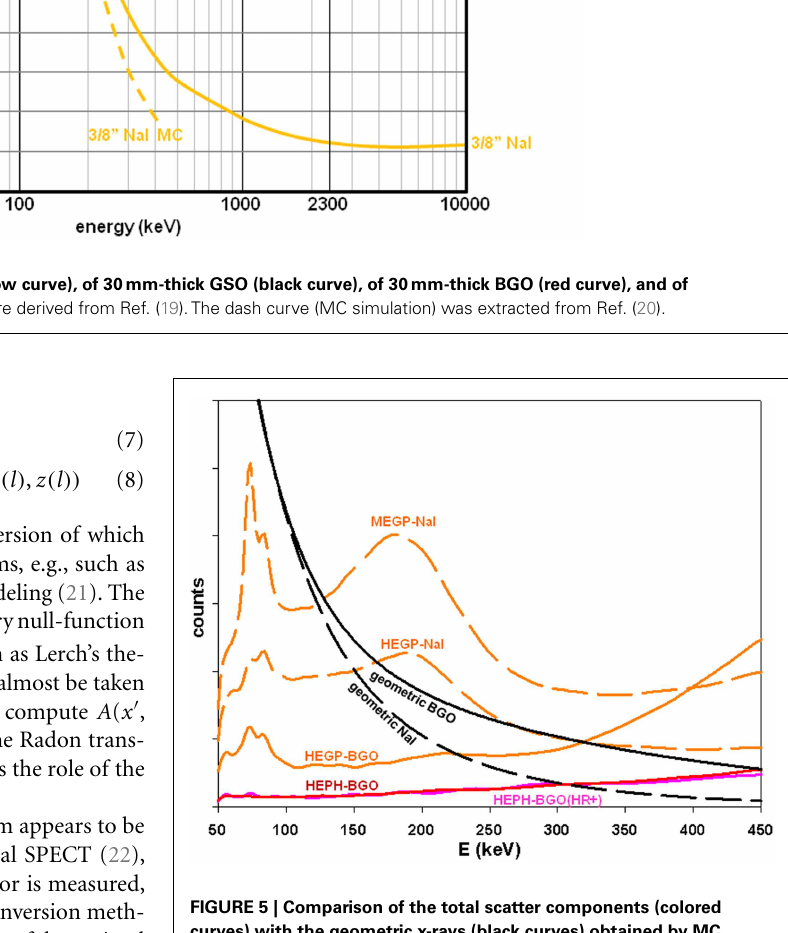
FIGURE 5 | Comparison of the total scatter components (colored curves) with the geometric x-rays (black curves) obtained by MC simulations for a 90 Y point source surrounded by 1cm of perpex and set 10cm in front of the collimator . Septa thickness is 1.4 and 3.2mm, hole diameter is 3.4 and 4.0mm, hole length is 42 and 40mm, for the MEGP and HEGP collimator, respectively. Front wall thickness of 5cm, aperture diameter of 8mm, focal length of 15cm for the HEPH collimator. 45cm × 25cm crystal: 3/8 (cid:48)(cid:48) -thick NaI and 30mm-thick BGO.The purple curve corresponds to the BGO prototype (see second last section).The BGO to NaI geometric ratio is 4.8 at 400keV, which is in line with the 4.9 predicted by previous MC simulations ( Figure 4